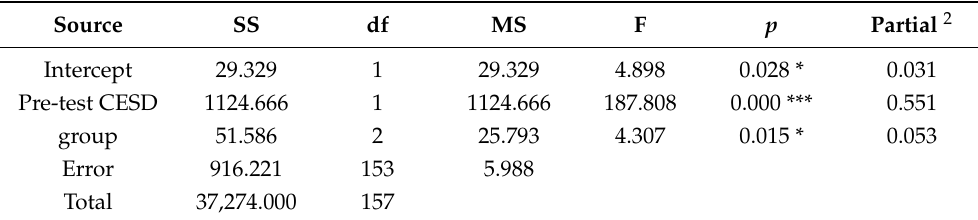
Total 37,274.000